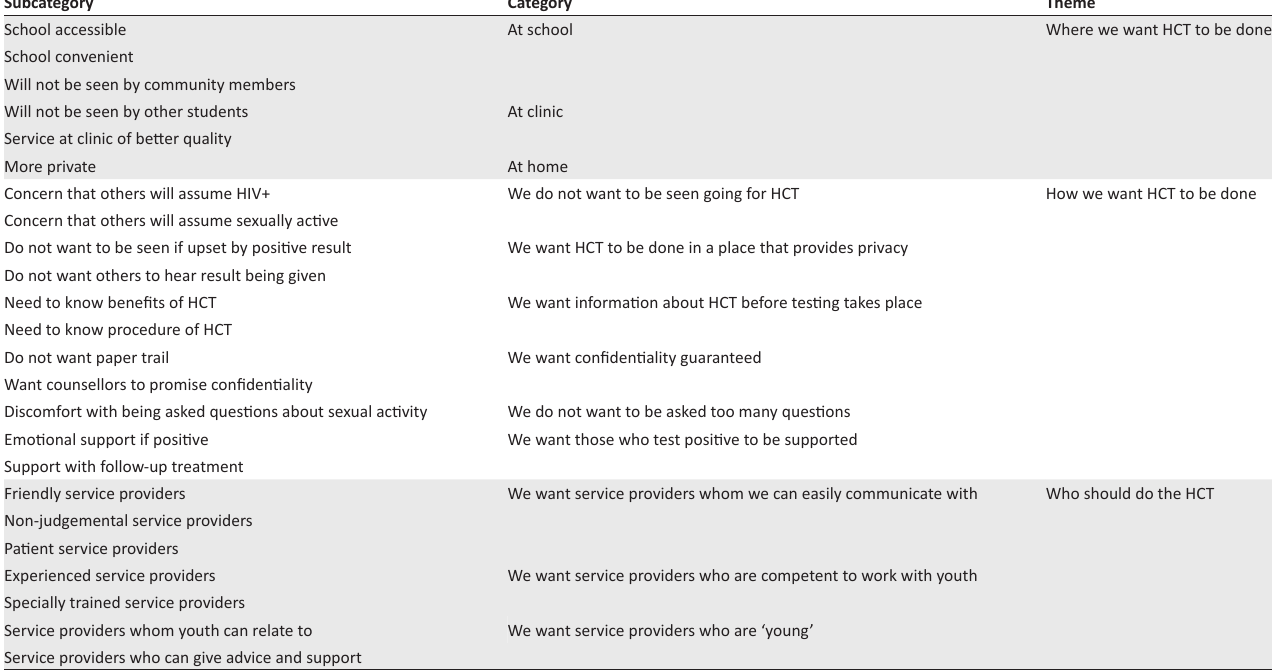
TABLE 3: Themes which emerged during data analysis.